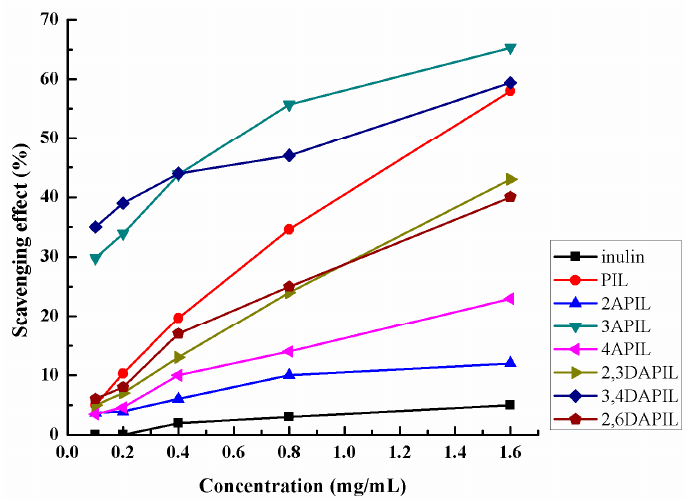
Figure 5. Hydroxyl-radical scavenging abilities of inulin and cationic inulin derivatives.